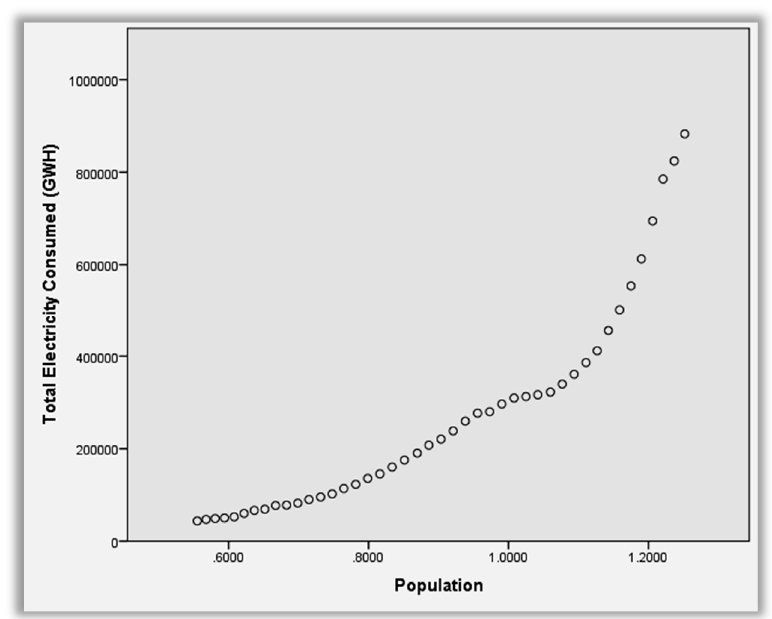
Figure 6. Plot between Population and TEC.